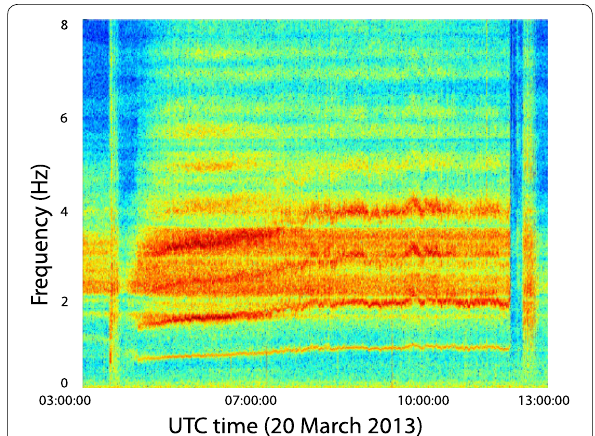
Fig. 6 Harmonic Tremor at White Island. Harmonic tremor recorded at White Island after a seismic quiescence of 20 min, and lasting for 8 h. The fundamental frequency evolves from ∼ 0.8 at the onset of the tremor to ∼ 1 Hz when it ends. The frequency of ∼ 0.8 Hz implies a source excitation of ∼ 1.3 s. We used a window of 512 samples with a 25-sample overlap to create the